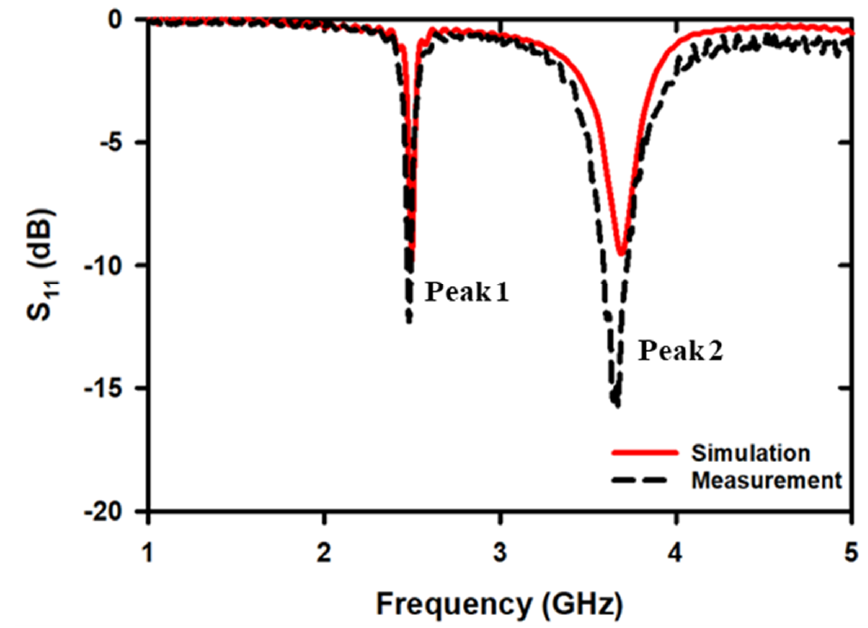
Figure 4. Comparison of simulated and measured S 11 spectra.